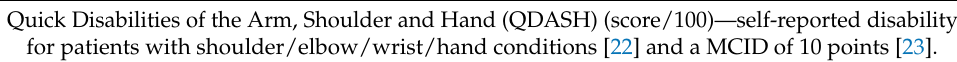
Table 1. Cont . Secondary Service—Related Outcomes and Explanatory Variables Quick Disabilities of the Arm, Shoulder and Hand (QDASH) (score/100)—self-reported disability for patients with shoulder/elbow/wrist/hand conditions [22] and a MCID of 10 points [23]. General health measures